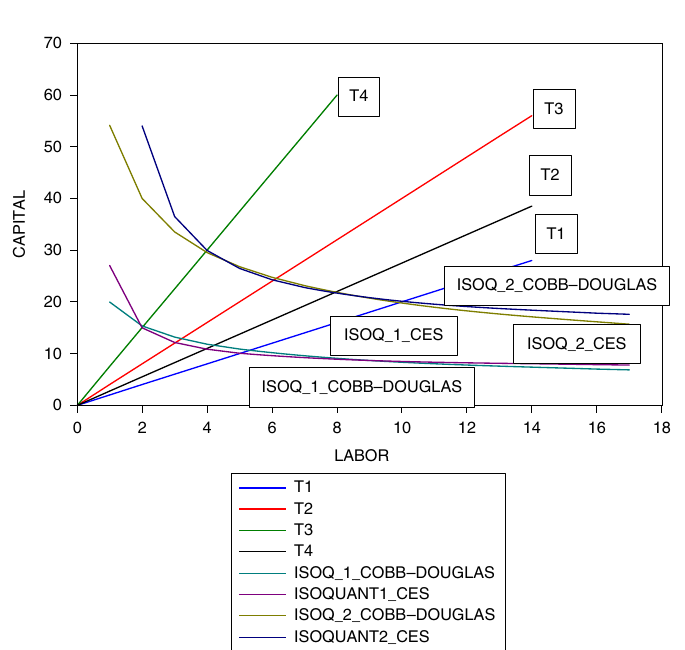
Table III. Hypothetical data on four fixed-proportions production functions